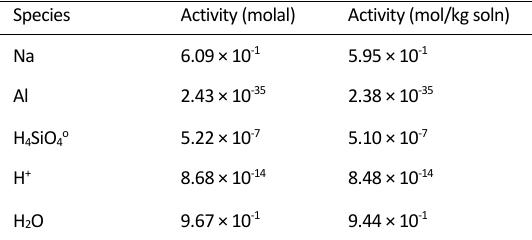
Table 4. Supernatant activities of species needed to calculate N‐A‐S‐ (H) solubility product for sample